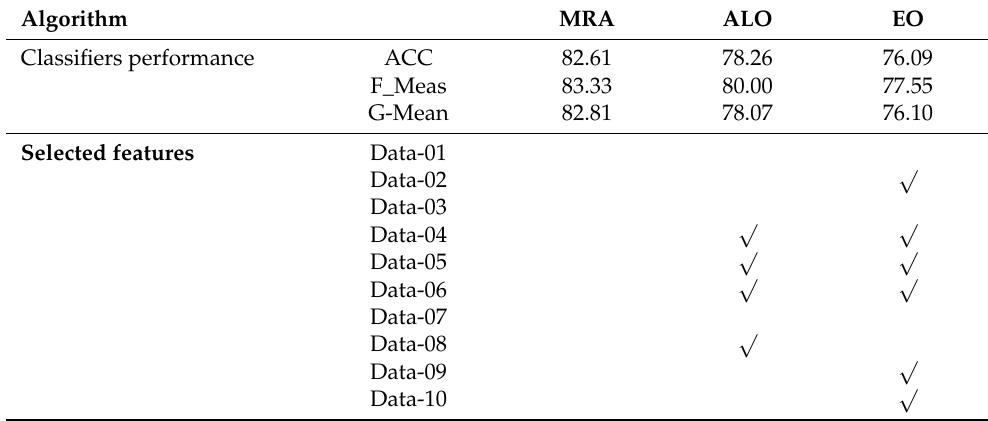
Table 7. The performance metrics and selected features by the selected